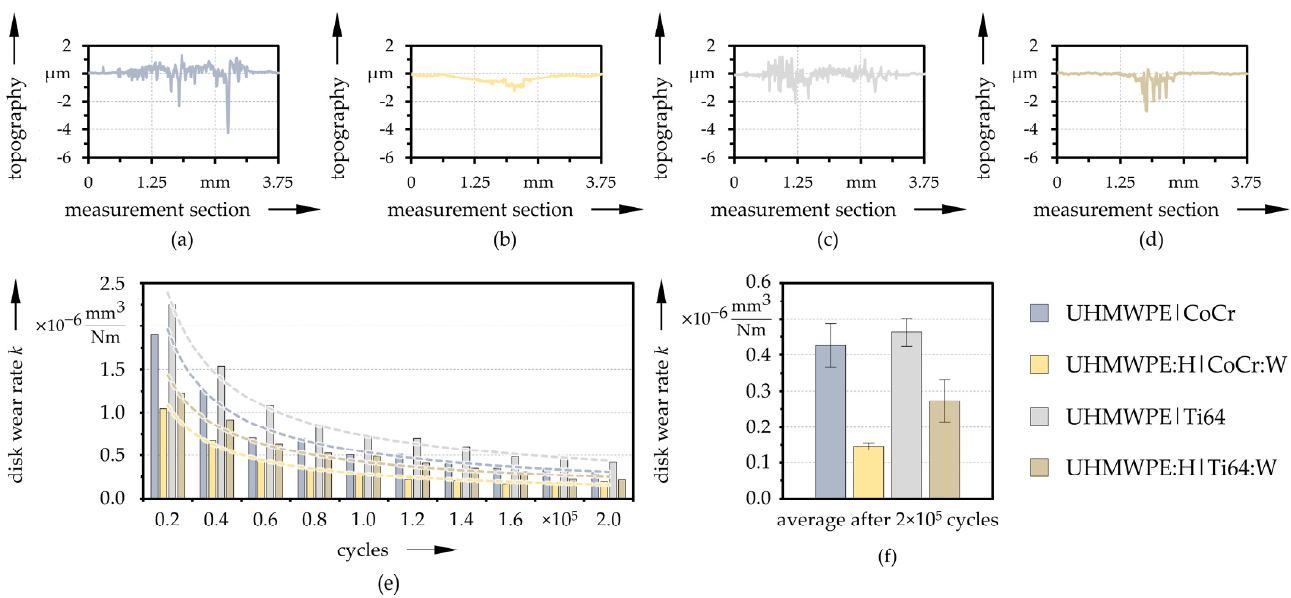
Figure 8. Exemplary cross sections of the wear track on the disks ( a – d ) as well as evolution of the disk wear coefficients with trend-lines ( n = 1) after each testing interval ( e ) and averaged values ( n = 3) after the entire test duration ( f ) for the reference and coated pairings.